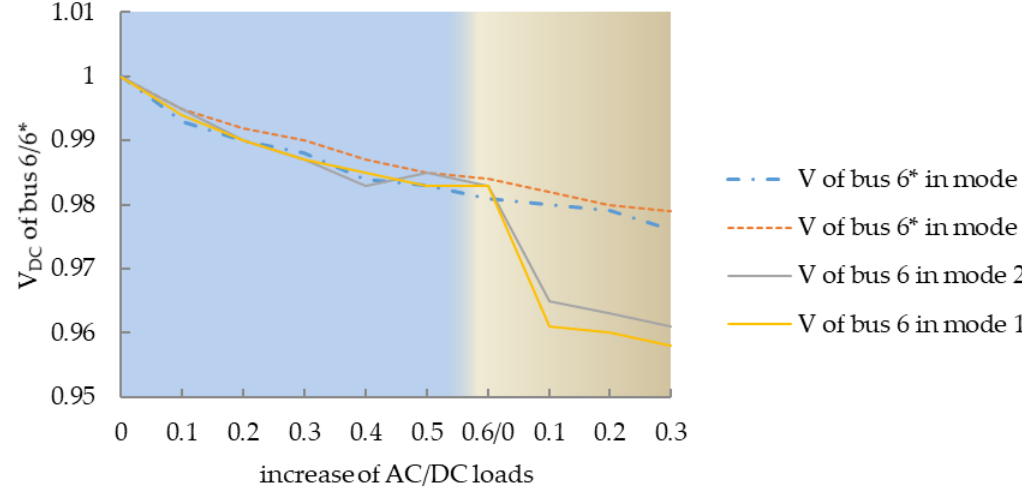
Figure 11. The distribution of the DC voltage of IHMG for the fluctuating AC/DC load.